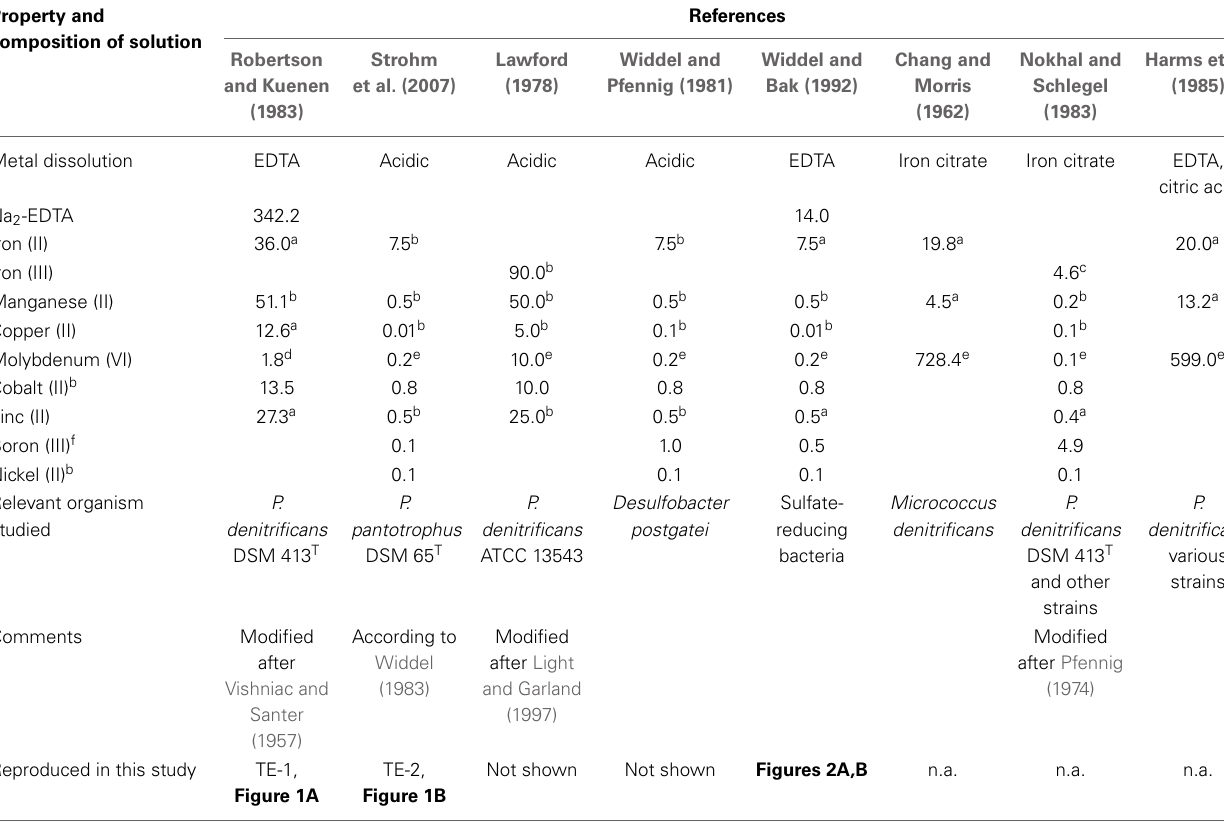
Table 1 | Compositions of frequently used trace element solutions in the literature (final concentrations in µ M in the medium). Property